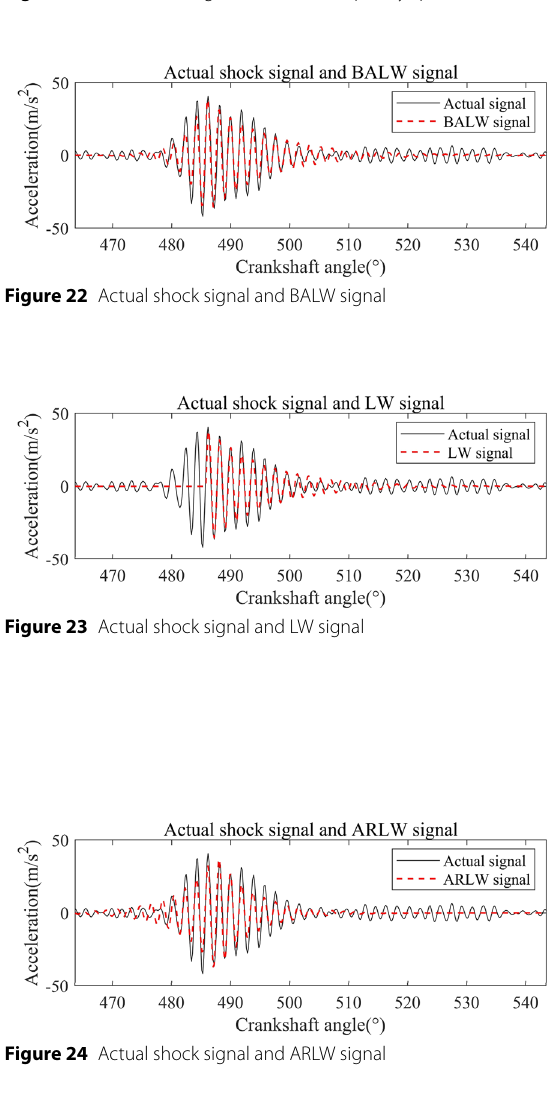
Figure 21 VMD mode signals and their frequency spectrum